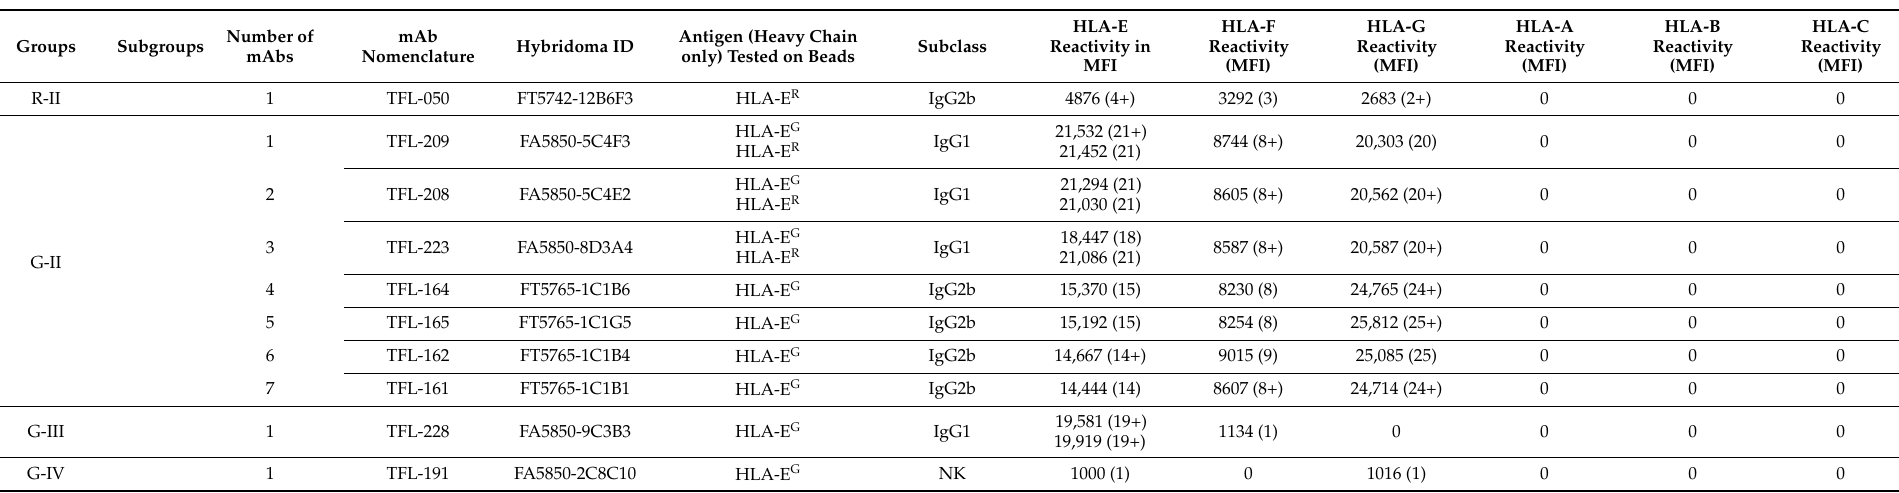
Table 3. HLA-Ib specific mAbs are non-reactive to HLA-Ia